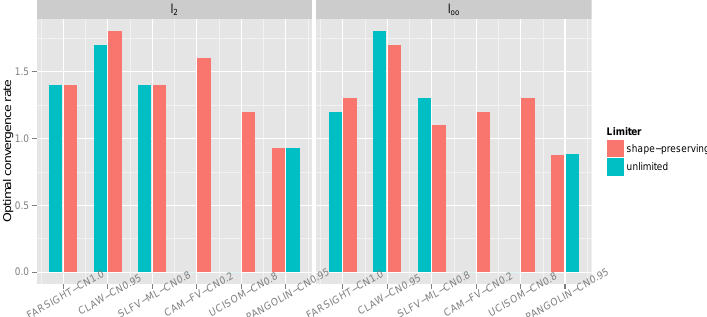
Figure 9. Optimal order of convergence computed by a least-squares regression on data from Fig. 8. Some models did not offer data without shape-preserving limiters (CAM-FV,